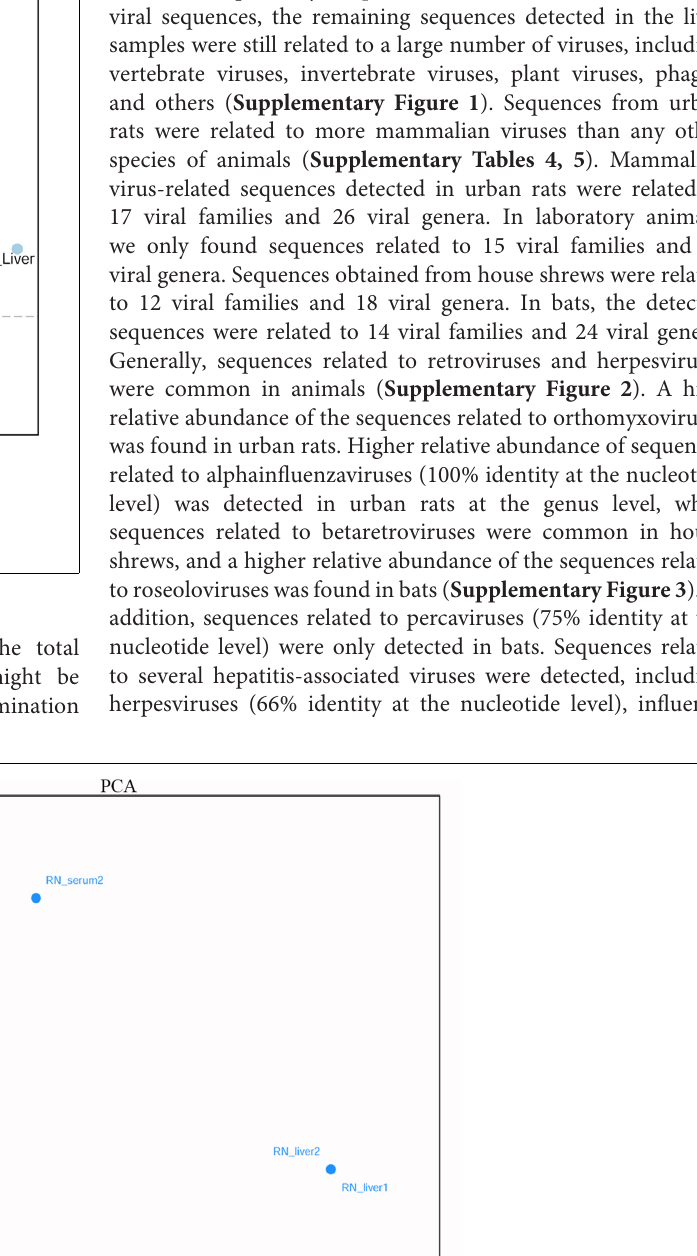
Frontiers in Microbiology |